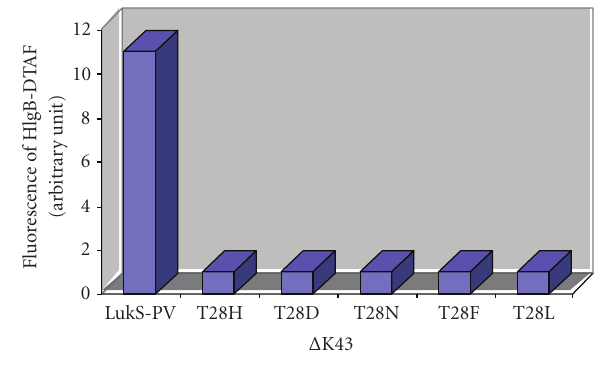
Figure 6: Determination of the secondary binding of a class F com- ponent mutated protein onto human PMNs. The determination of the binding is made by measuring the fluorescence of HlgB- fluorescein (0.75 nM) on bound mutated class S proteins (2nM).